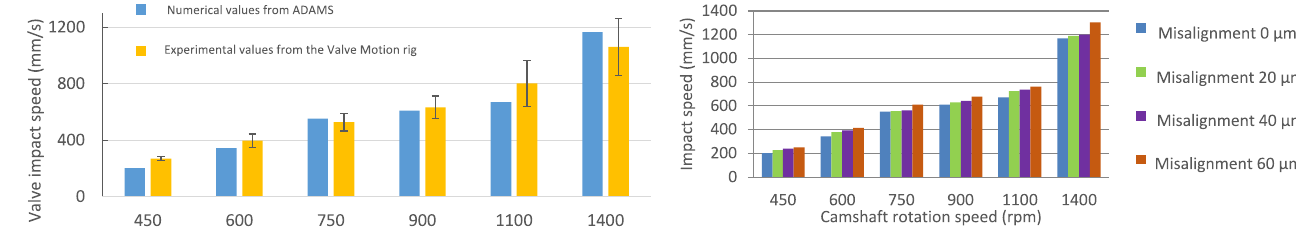
Fig. 10. Controlled seat misalignment relative to valve guide.